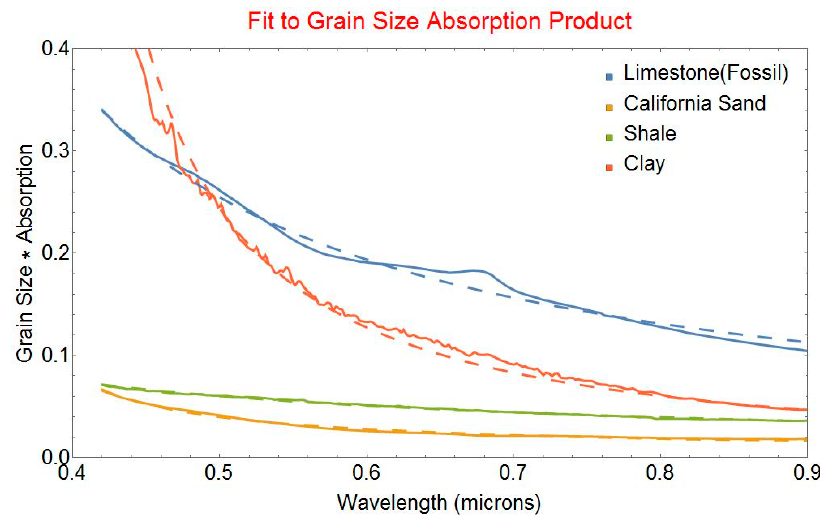
Figure 3. Comparison of the dimensionless parameter grain size times absorption coefficient estimated using Formula (23) for various mineral compounds (solid lines) with the fit (dashed lines) obtained using Equation (25). The fit parameters are given in the corresponding entries of Table 4. The spectral features seen in the experimental reflectance of the Trenton limestone sample are due to an interstitial chlorophyll-a residue lying on top of the limestone.